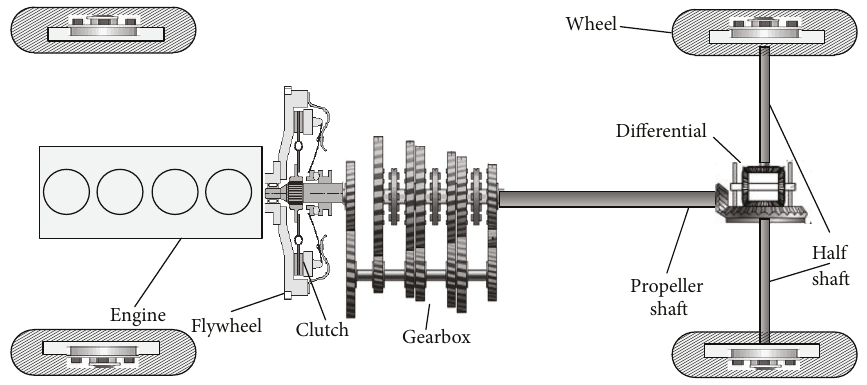
Figure 1: Overall structure of the AMT truck.